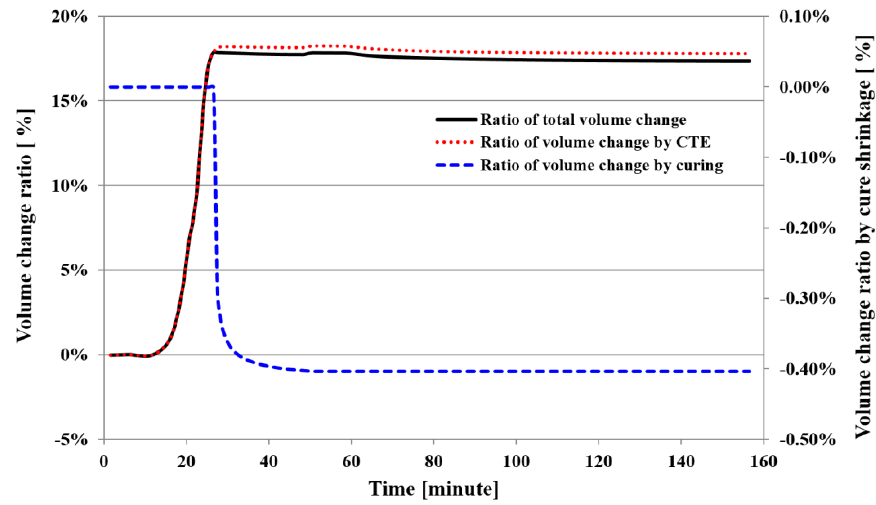
Figure 6. Volume change ratio of PPG as a function of temperature and time.